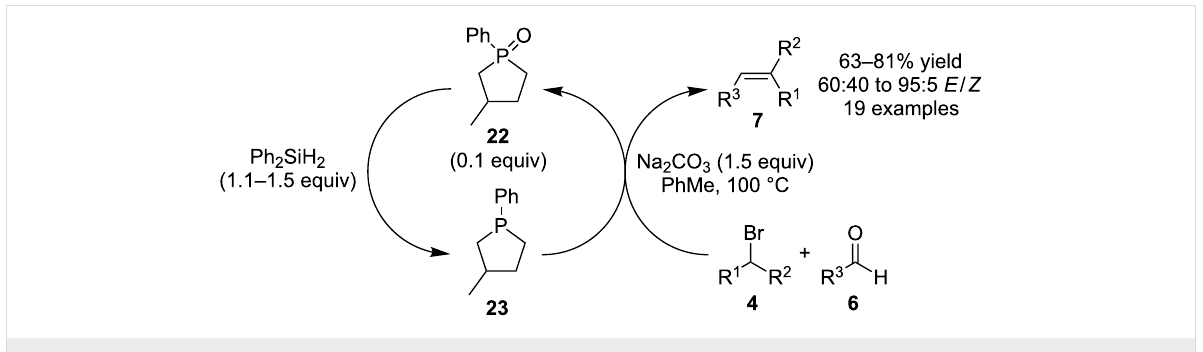
Scheme 7: Phosphine-catalyzed Wittig reactions.